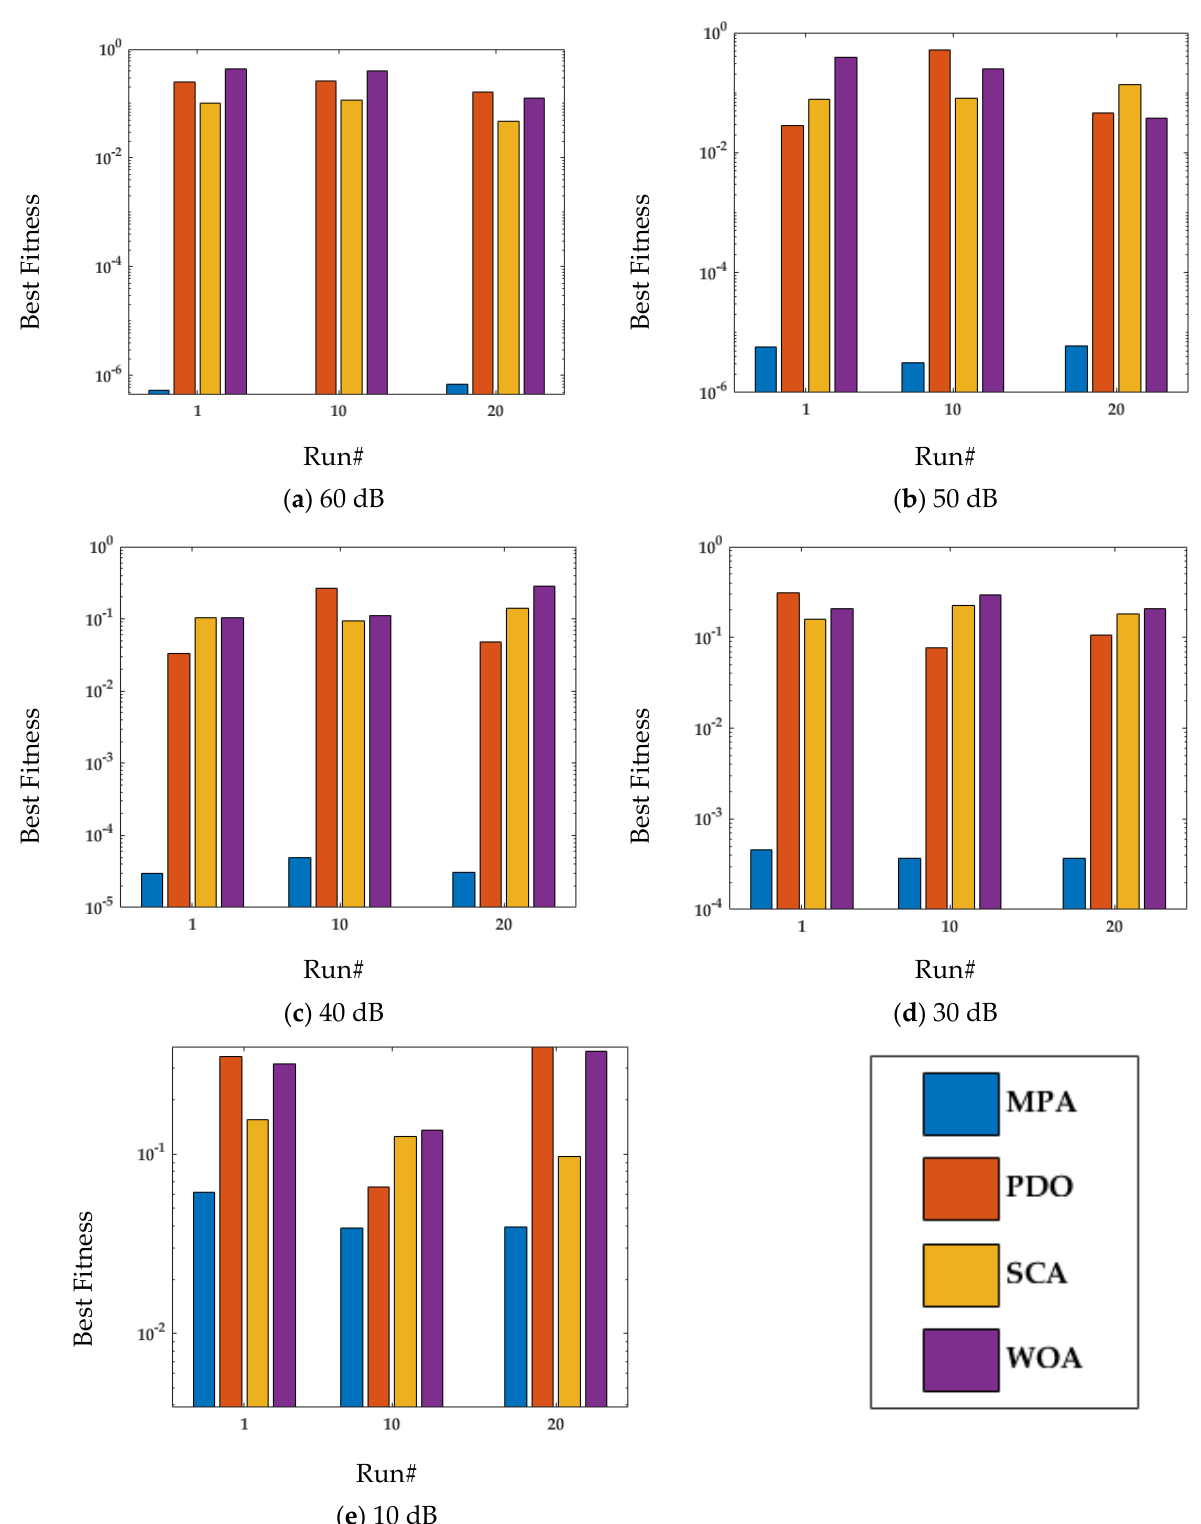
Figure 6. Run# fitness comparison of MPA with PDO, SCA and WOA at Np = 100 and T = 1000 for case study 1. Table 3. Estimated weights analysis w.r.t generation and population sizes at 50 dB noise for case study 1.